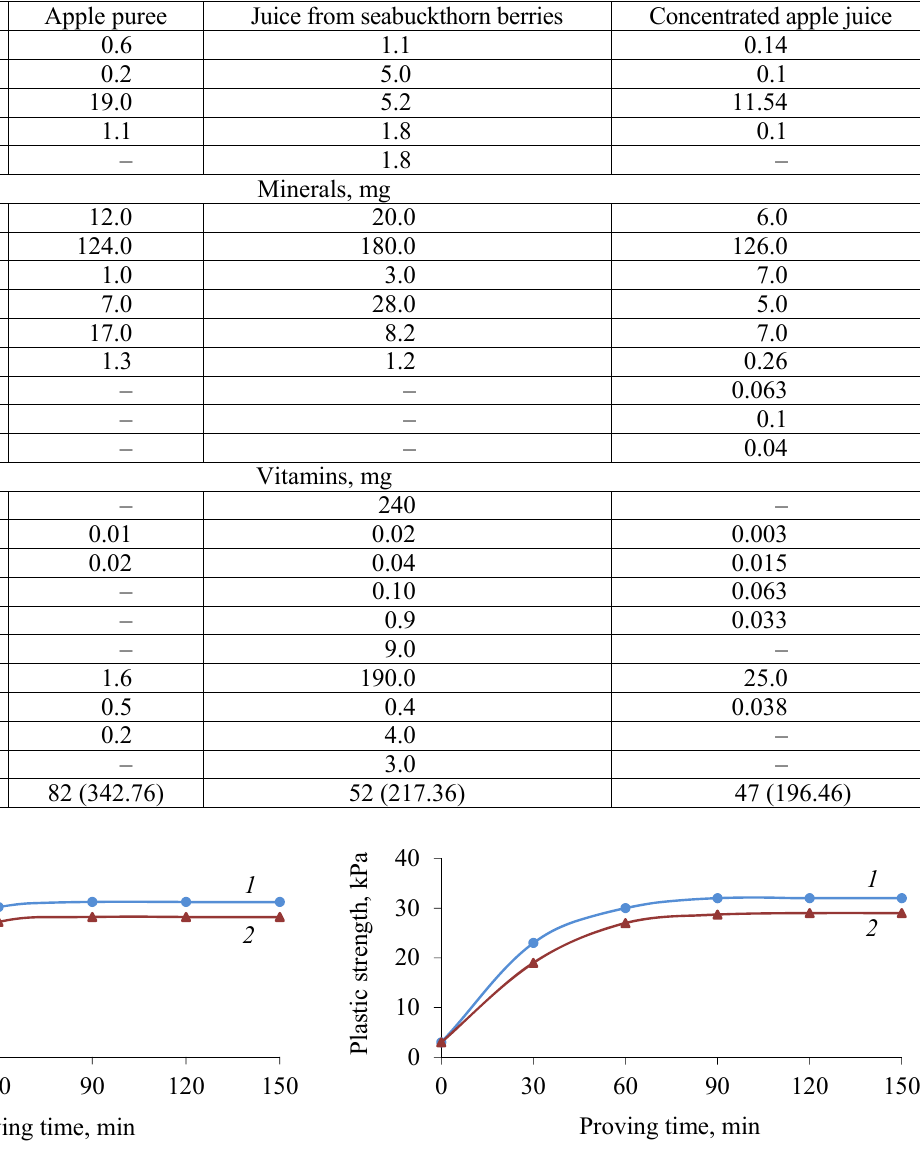
Fig. 2. Change in the proving of the plastic strength of jelly mass of the composition of pectin and: ( 1 ) sugar + molasses + apple puree; ( 2 ) stevioside + apple puree.